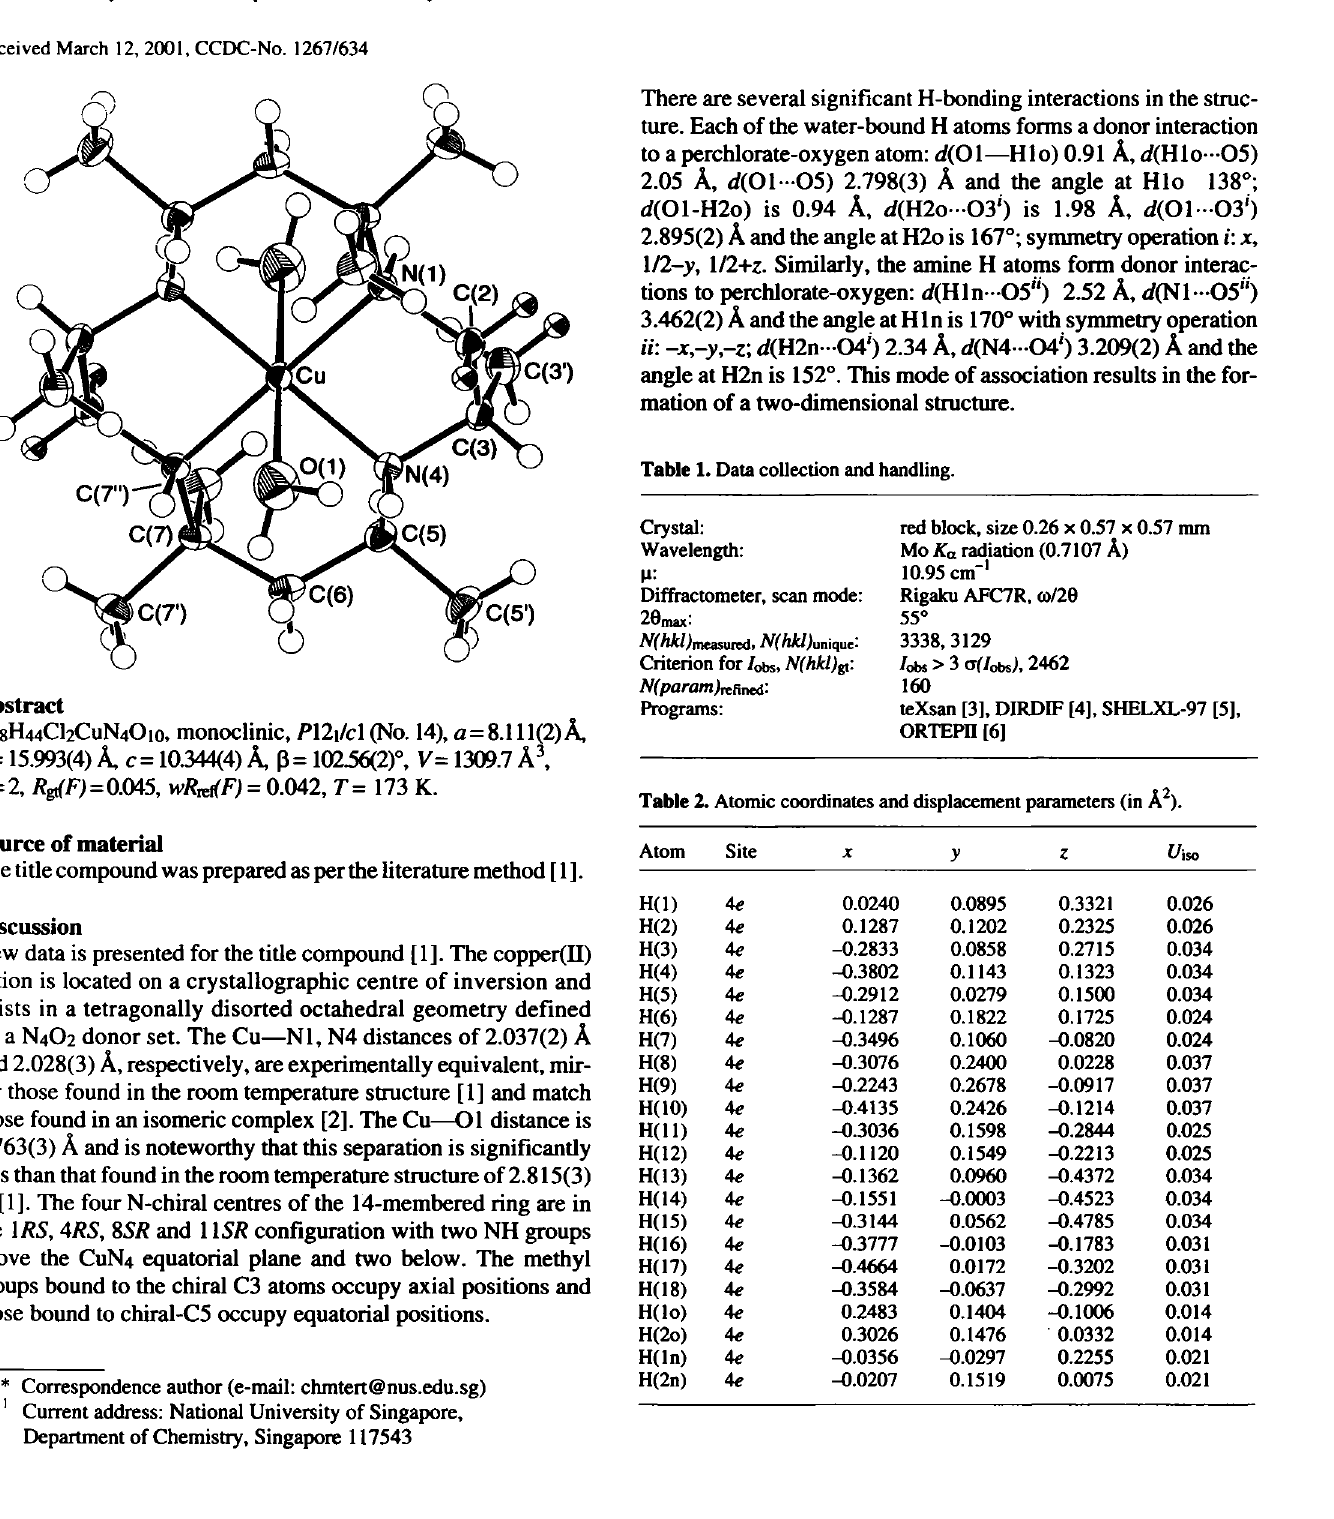
Table 1. Data collection and handling.